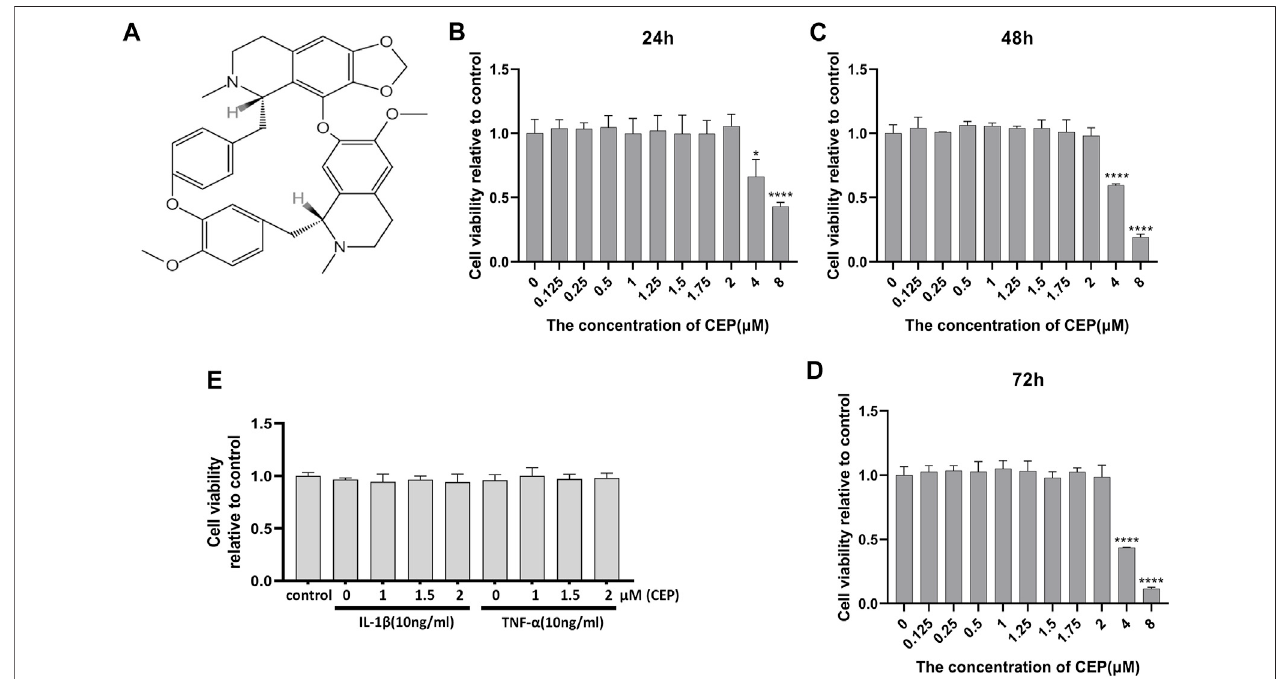
FIGURE1| EffectsofCEPonchondrocyteviability. (A) Molecularstructure ofCEP. (B,C,D) CellsweretreatedwiththeindicatedconcentrationsofCEPfor24,48, and 72 h. Mouse chondrocyte viability was evaluated by CCK-8 assay. (E) Chondrocytes were exposed to 10 ng/ml IL-1 β or TNF- α with or without CEP (1, 1.5, and 2 μ M), and cell viability was determined by CCK-8 assay. All experiments were repeated independently three times. Values are expressed as mean ± SD; * p < 0.05 and **** p < 0.0001 vs. the control